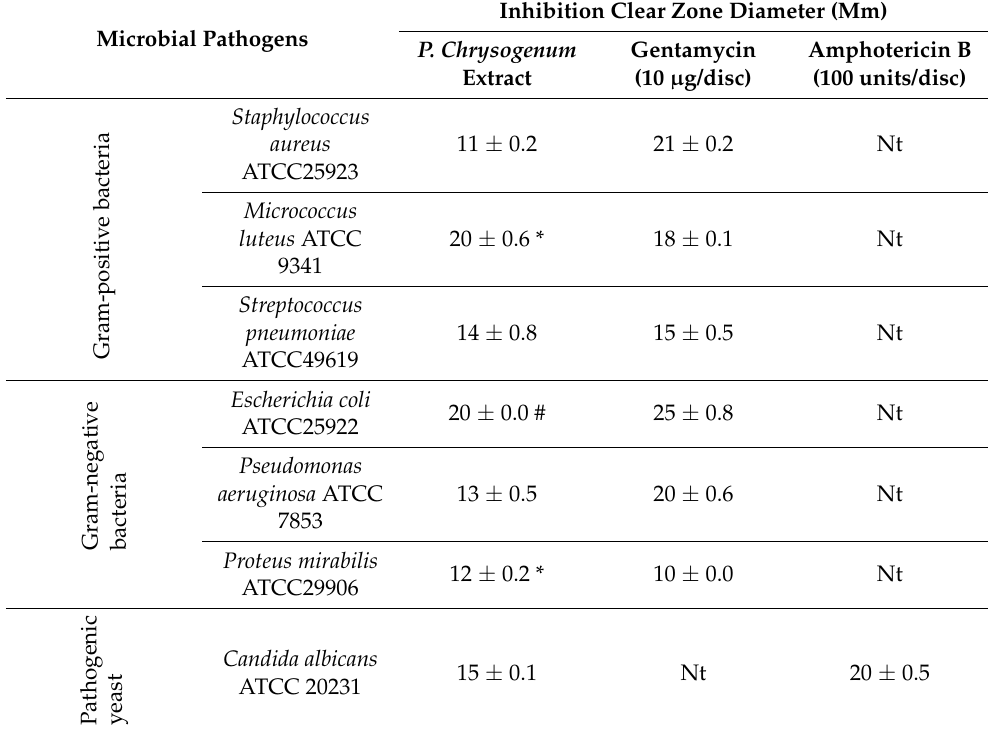
Table 1. The antibacterial and anticandidal effect of ethyl acetate extract of P. chrysogenum MZ945518 by well diffusion technique.